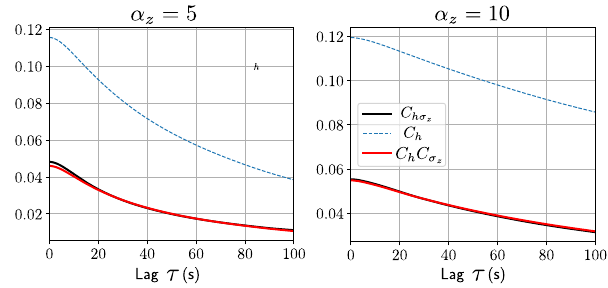
C C σ for h σ z ¼ h z 3 . 5 , and α 0 h ¼ r ¼